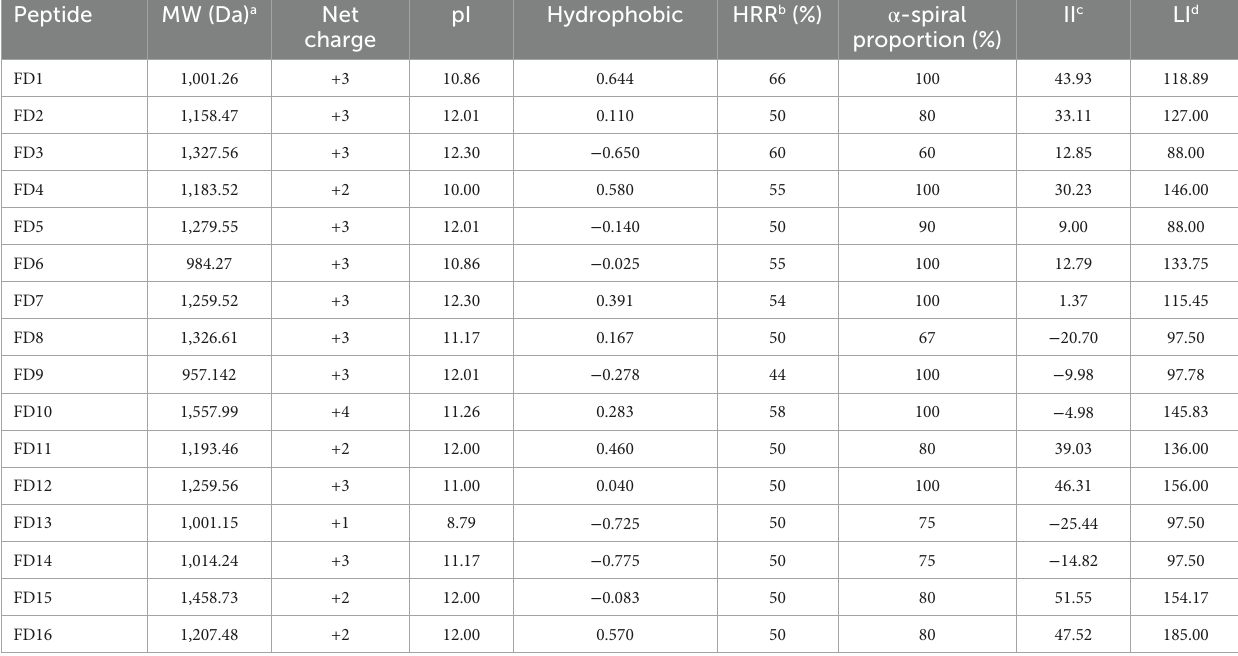
TABLE 2 Comparison of physicochemical properties of candidate peptides.